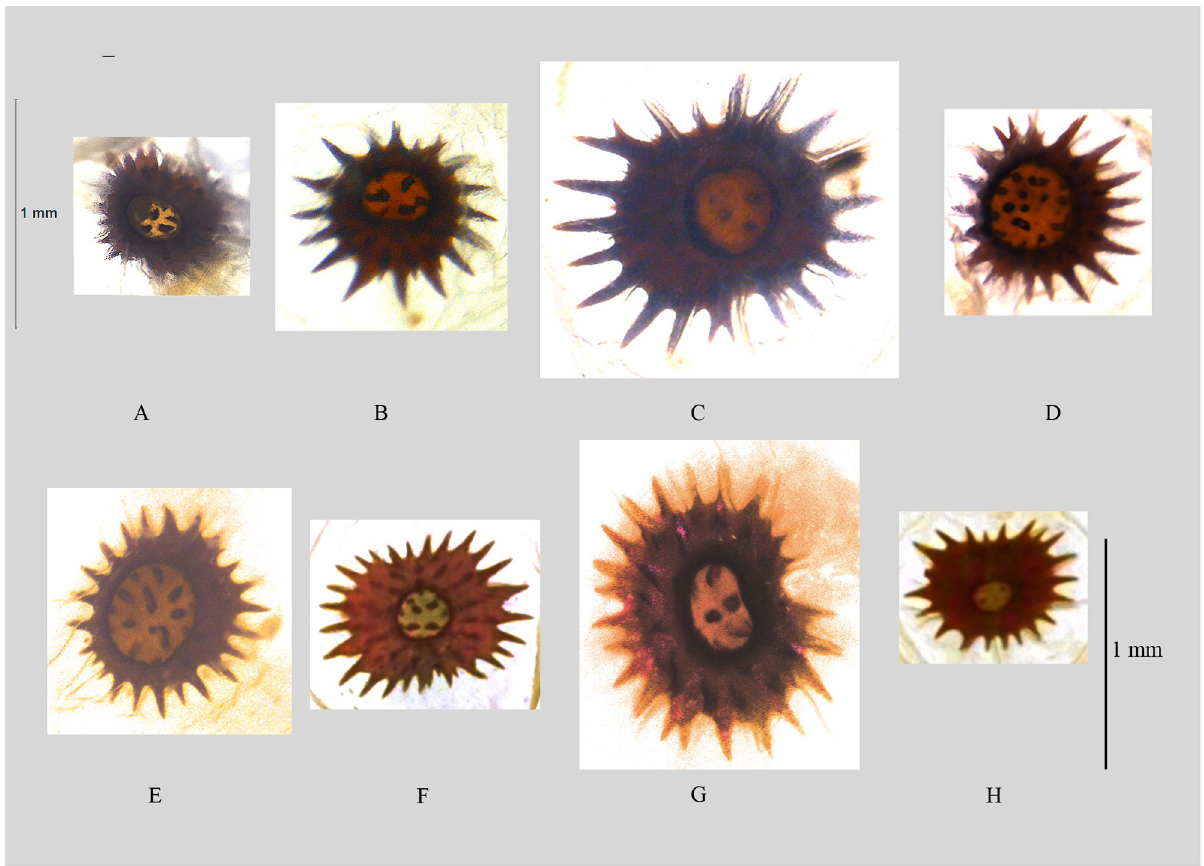
Fig 7. Signum of Psyra species. A. P . gracilis B. P . angulifera C. P . cuneata D. P . dsagara E. P . similaria F. P . falcipennis G. P . crypta H. P . spurcataria